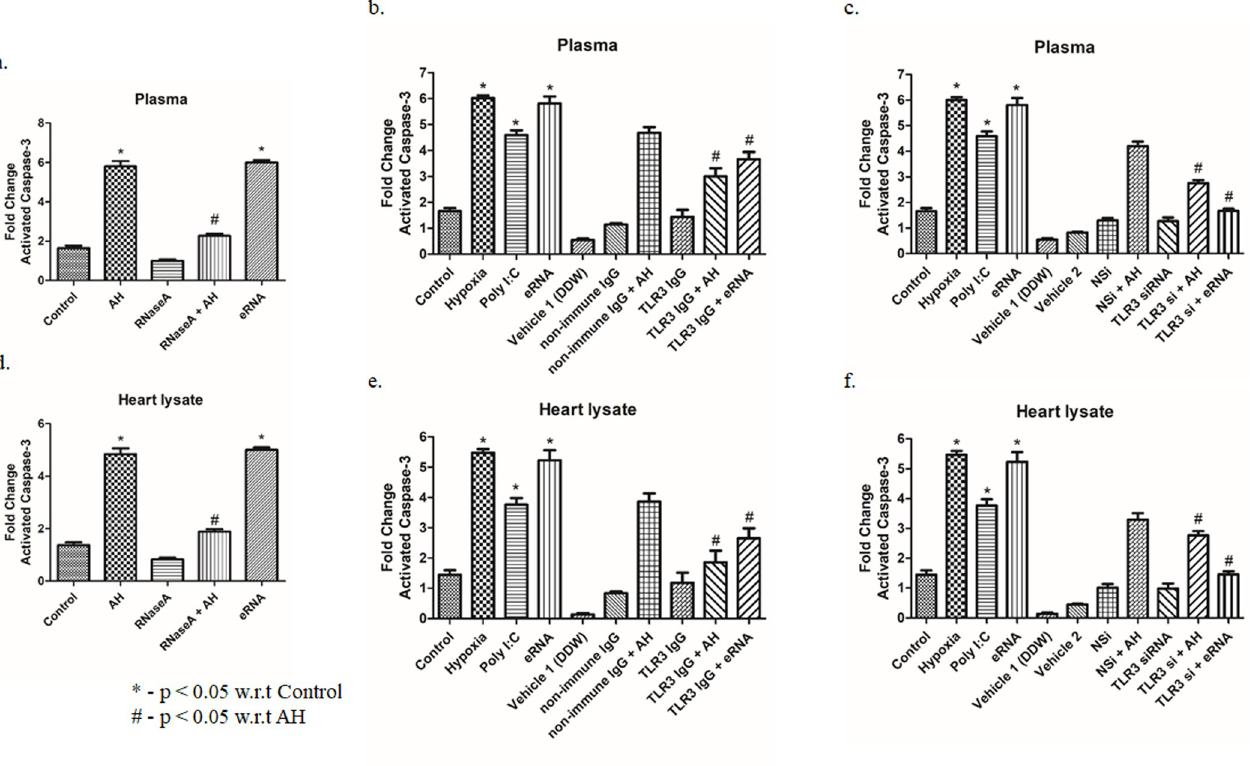
Fig 6. AH induced cTrop-T release is mediated by activation of caspase-3. Estimation of activated Caspase-3 was done after (a) eRNA injection (80 μ g/kg BW; 6 hrs prior to AH exposure) and RNaseA pre-treatment (1mg/kg BW; 2 hrs prior to AH exposure) in plasma, (b) TLR3 IgG treatment in plasma (c) TLR3 siRNA treatment (40 mg/kg BW; 2 hrs prior to AH exposure) in plasma, (d) eRNA injection (80 μ g/kg BW; 6 hrs prior to AH exposure) and RNaseA pre-treatment (1mg/ kg BW; 2 hrs prior to AH exposure) in heart lysate, (e) TLR3 IgG treatment (40 mg/kg BW; 2 hrs prior to AH exposure) in heart lysate and (f) TLR3 siRNA treatment in heart lysate. Data are shown as mean ± SEM (n = 5/group/treatment) from one experiment representative of three independent experiments, all performed in triplicate. One-way ANOVA revealed statistical significance in the results ( � p < 0.05 groups w.r.t control; #p < 0.05groups w.r.t AH).